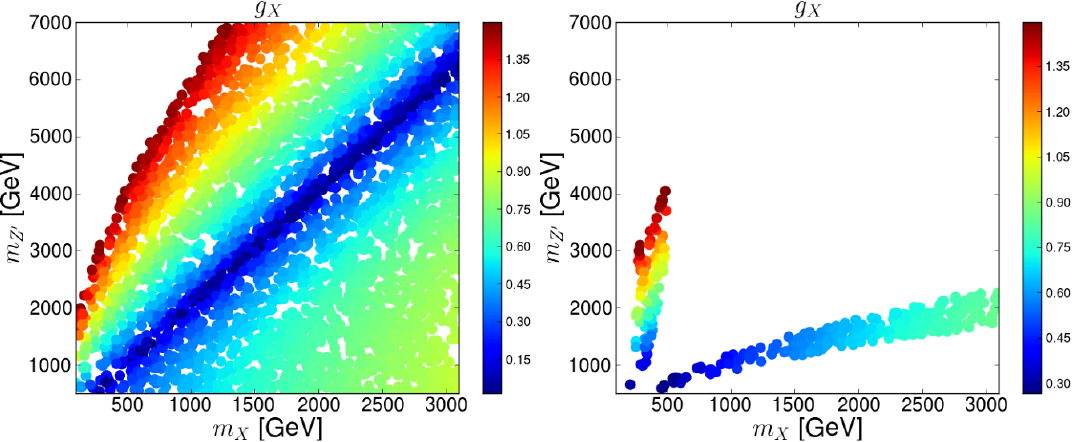
Figure 8 . (Left): parameter region which accommodates the observed DM relic density. (Right): parameter region which explains both DM relic density and b ! s‘ + ‘ (cid:0)